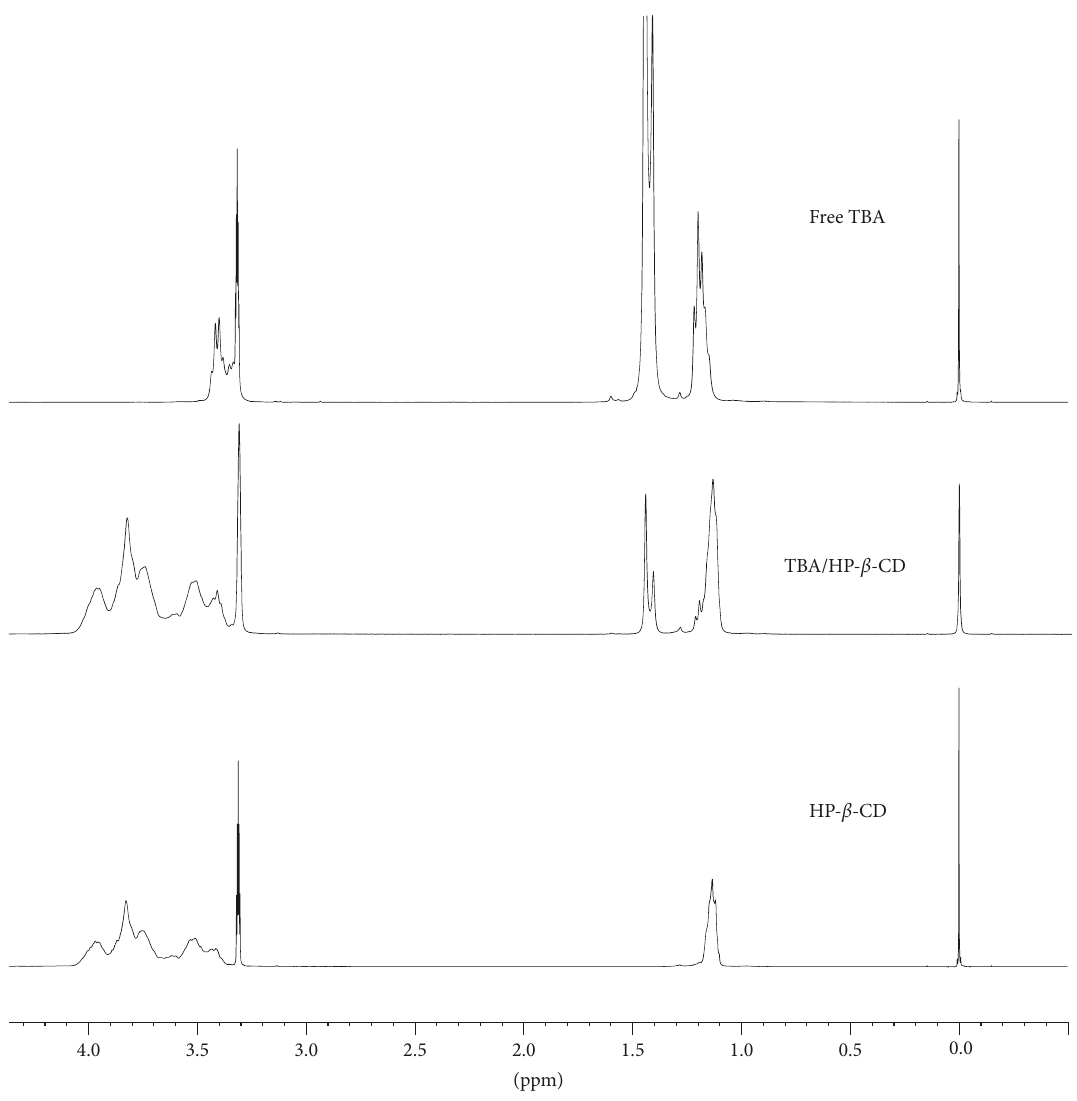
cavity, along with no significant changes on the protons of the external surface of CD, are consistent with host-guest